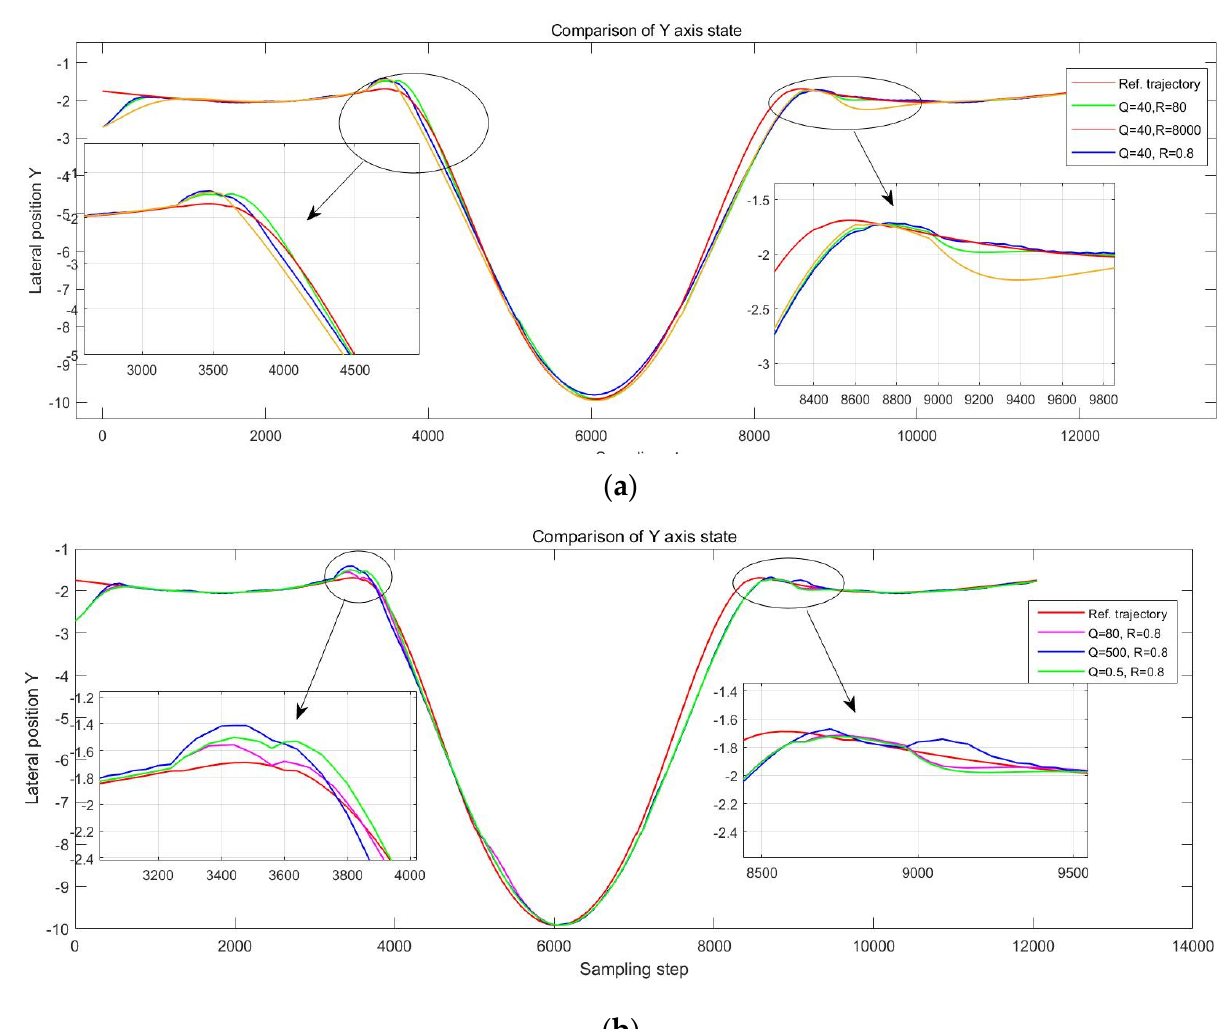
Figure 4. ( a ) Shows the tracking difference with reference path after changing the weighting parameter R; Q = 40, R = 0.8 achieves the best performance. ( b ) Compares yaw angle after changing the weighting parameter Q; those performances look similar, but the pink line (Q = 80, R = 0.8) is still closer to the red reference line.